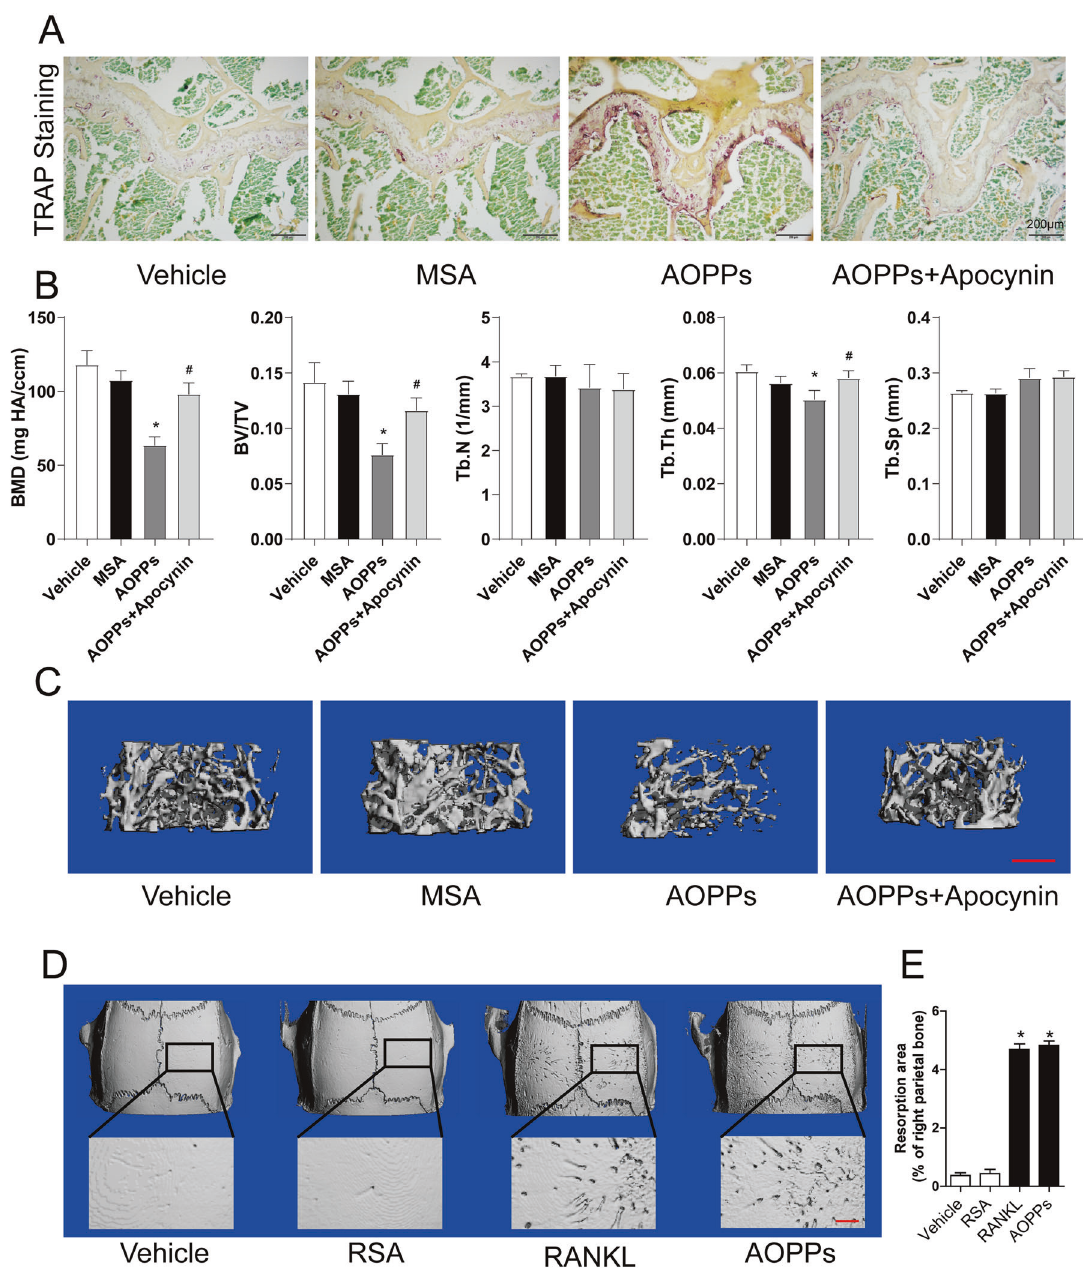
Fig. 8 Chronic exposure to AOPPs induced osteoclastogenesis and bone loss in vivo. The 3-month-old mice were treated by daily intraperitoneal injection of AOPPs for 16 weeks with or without apocynin, the samples of proximal tibias were used for TRAP staining and μ CT analyses. A Chronic loading of AOPPs induced the increase of TRAP positive cells, which could be inhibited by administration of apocynin. B AOPP challenge decreased the BMD (bone mineral density), BV/TV (Bone Volume/Total Volume) and d Tb.Th (Trabecular Thickness), but not Tb.N (Trabecular Number) and Tb.Sp (Trabecular Spacing), which could be alleviated by administration of apocynin. C Representative images of μ CT three-dimensional reconstruction in proximal tibias. D Local AOPPs aggravated bone resorption in vivo. Sprague – Dawley rats were injected subperiosteally over bilateral parietal bone. Representative images of μ CT three-dimensional reconstruction. E The resorption area was calculated by image J software. Scale bars = 1 mm. * p < 0.05 versus the vehicle-treated group; # p < 0.05 versus AOPPs